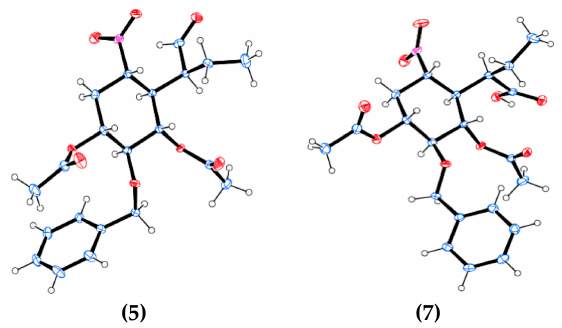
Figure 2. X-ray structures of compounds 5 and 7 .